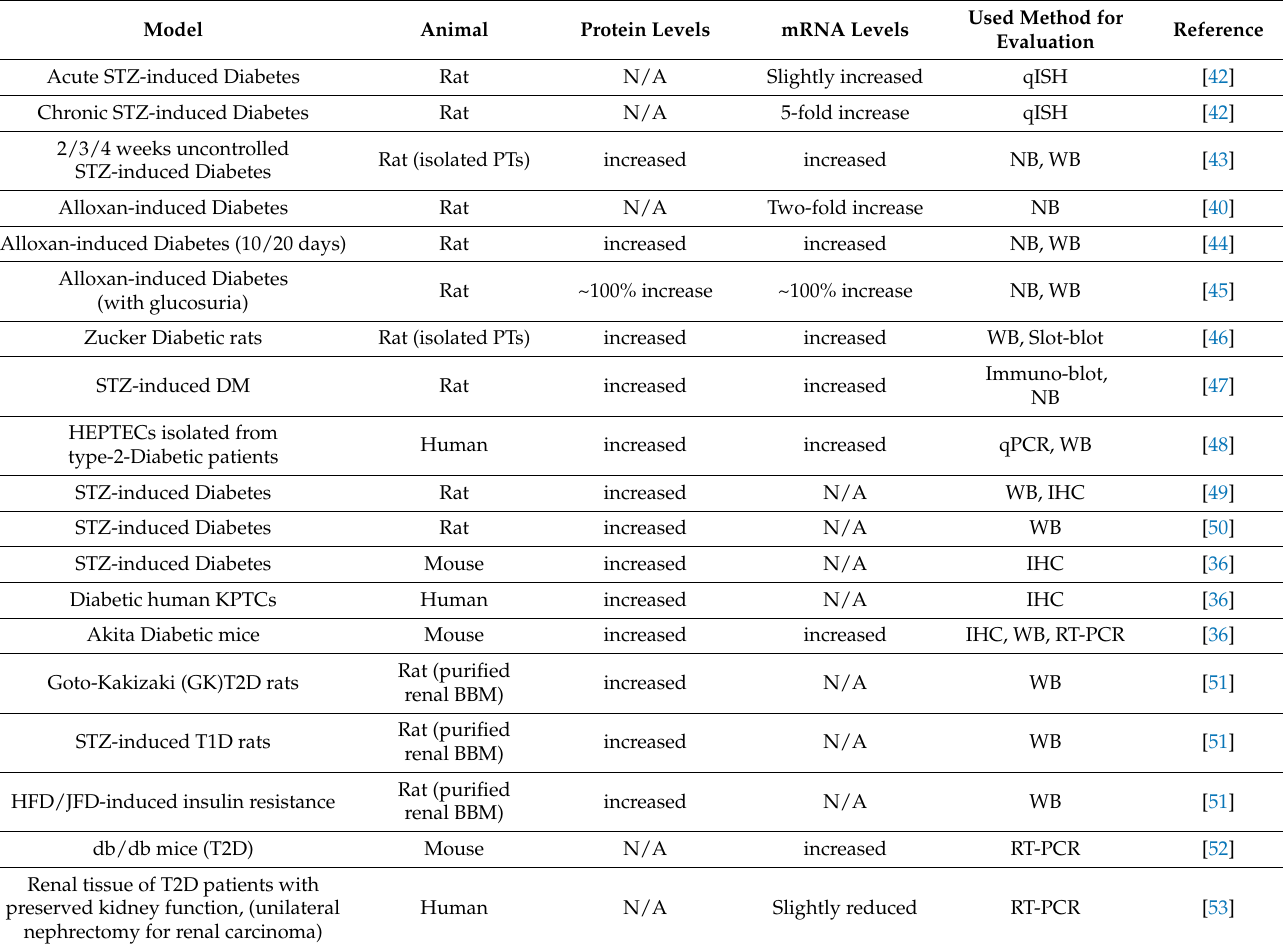
Table 1. KPTC-GLUT2 expression under